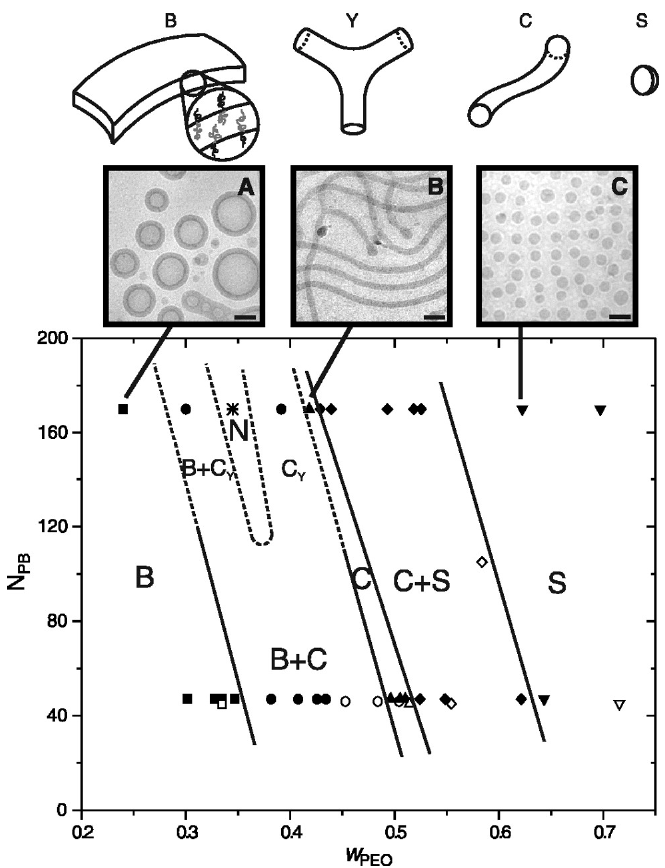
Figure 14. Morphology diagram for PB-PEO in water (1 wt %) as a function of molecular size and composition, where N PB and W PEO are the degree of polymerization and weight fraction of the PB and PEO blocks, respectively. Reprinted from Reference [84]. (Copyright (2003) American Association for the Advancement of Science).